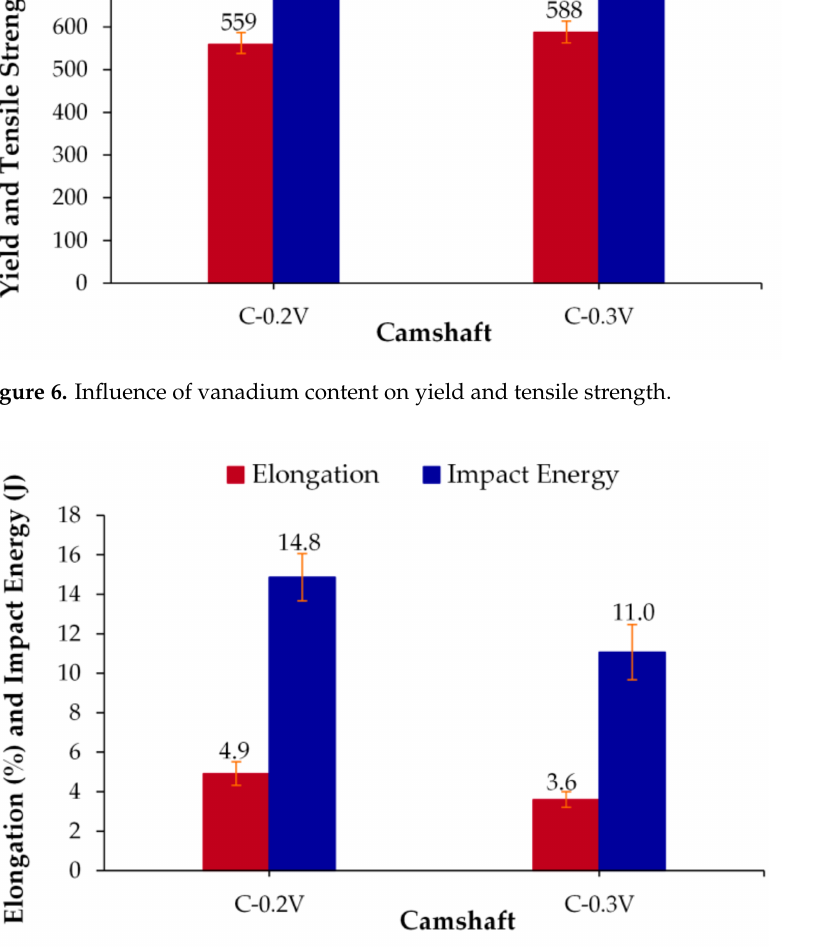
Figure 7. Influence of vanadium content on impact toughness and